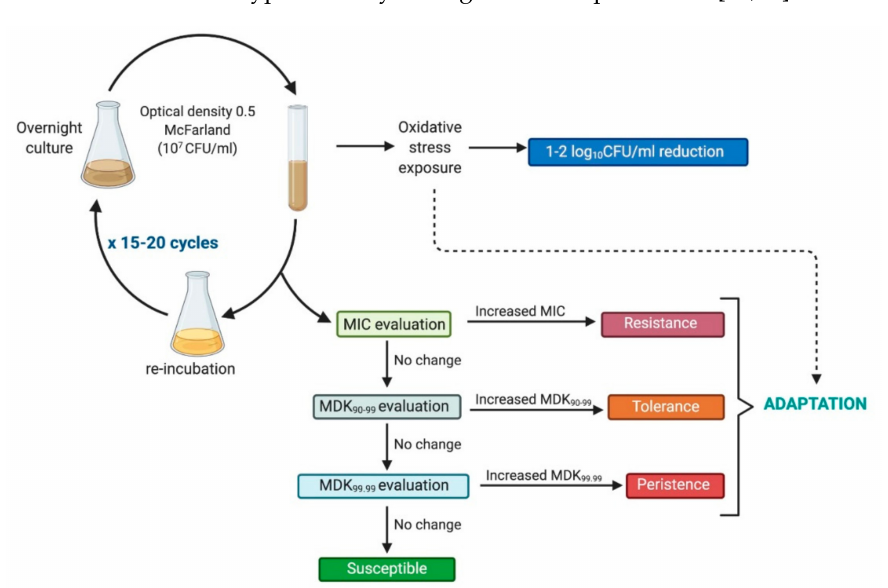
Figure 3. Framework for photoinduced adaptation